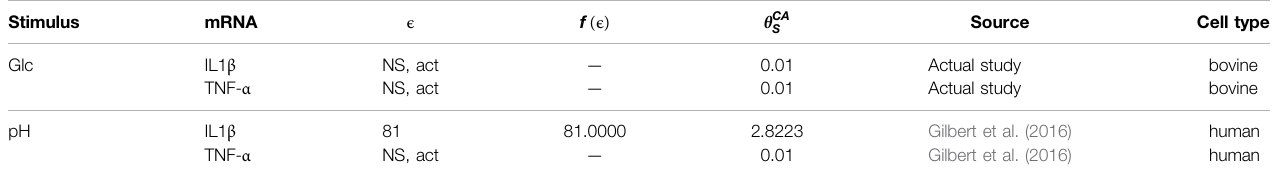
TABLE 3 | Individual weighting factors for the in fl ammation submodel. ϵ : x-fold mRNA expression, θ CA S : cell activity and stimulus-speci fi c weighting factor. Stimulus